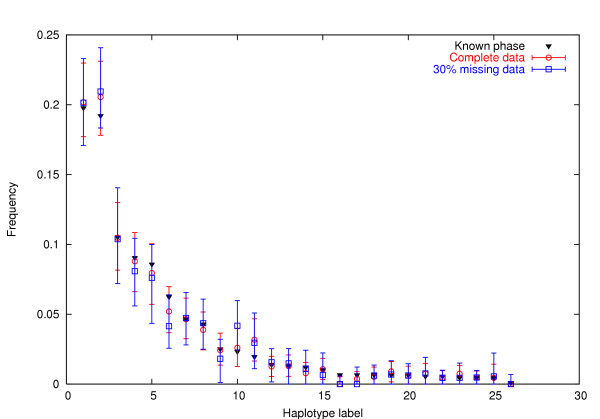
Seven loci SNP data with 30% missing alleles. 95% CIs for haplotype frequencies estimated from seven loci SNP phase-unknown data with 0% and 30% missing data. Frequencies derived from phase-known data also shown.